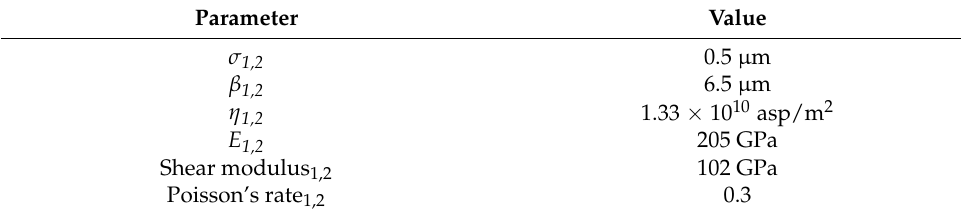
Table 5. Parameters of surface roughness.